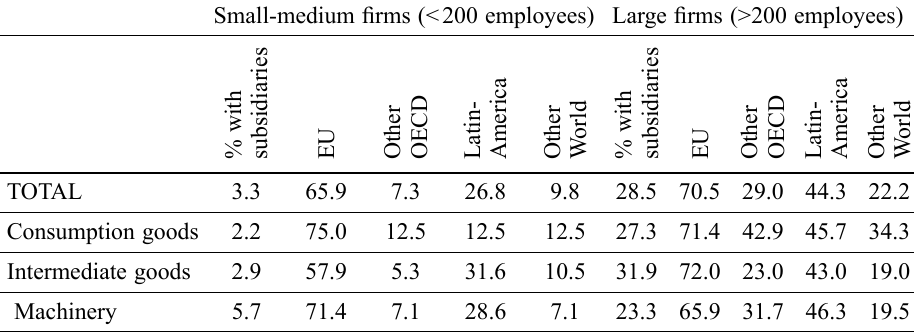
Table 1. Affiliates of Spanish manufacturing